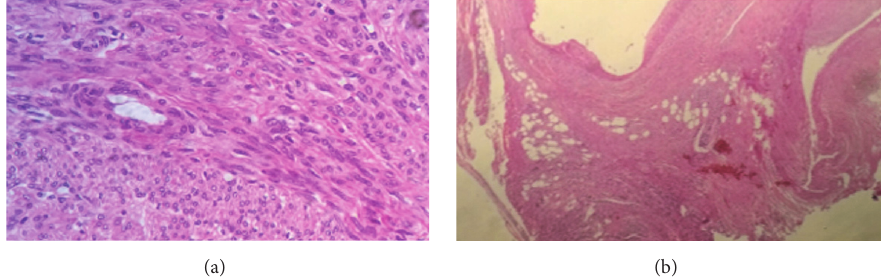
Figure 5: Histopathological analysis. Microscopic images of pelvic-abdominal mass (a) show intertwining bundles of smooth muscle cells and microscopic images omentum (b) show multiple irregular but discrete smooth muscle proliferation (leiomyomatous